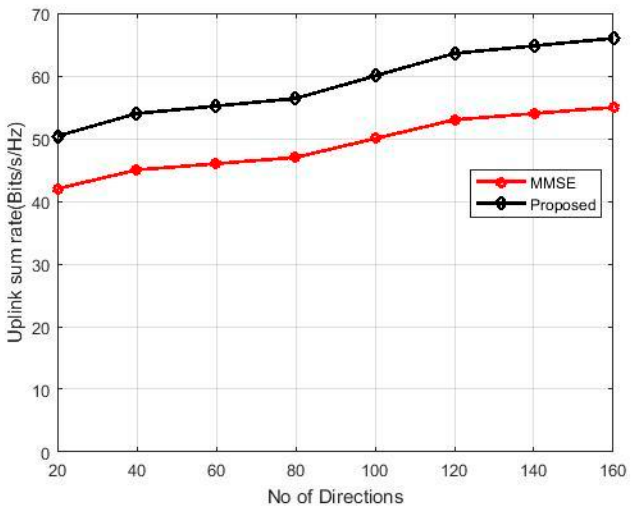
Figure 5. Performance of Uplink sum rate. Technologies 2018 , 6 , x FOR PEER REVIEW